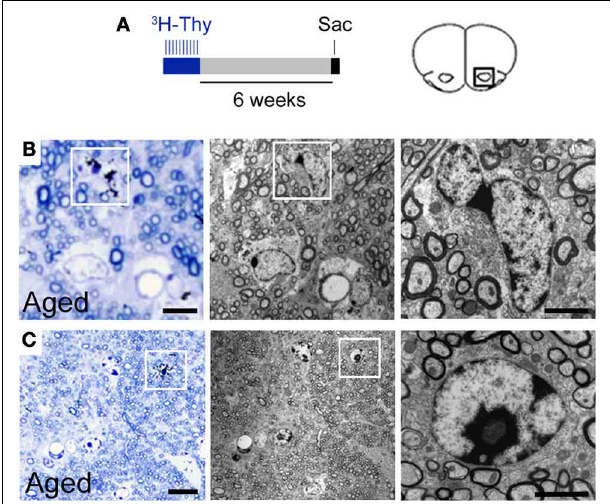
FIGURE 5 | Thymidine incorporation assay supports the generation of new oligodendrocytes in the aged RMS. (A) Animals received ten consecutive doses of 3H-Thy cells (dose/day) and were euthanized 6 weeks after. (B) Light and electron microscopy images showing a labeled cell (boxes) with irregular contours and light cytoplasm, with few intermediate filaments. The nucleus was fusiform and contained dense chromatin that was peripherally distributed. This cell contained features which bore a resemblance to astrocytes and oligodendrocytes. (C) Light and electron microscopy images showing a typical oligodendrocyte labeled with 3H-Thy (boxes). Sac, sacrifice. Scale bar: B = 5 µ m, detail in (B) 2 µ m, C = 10 µ m, detail in (C) = 2 µ